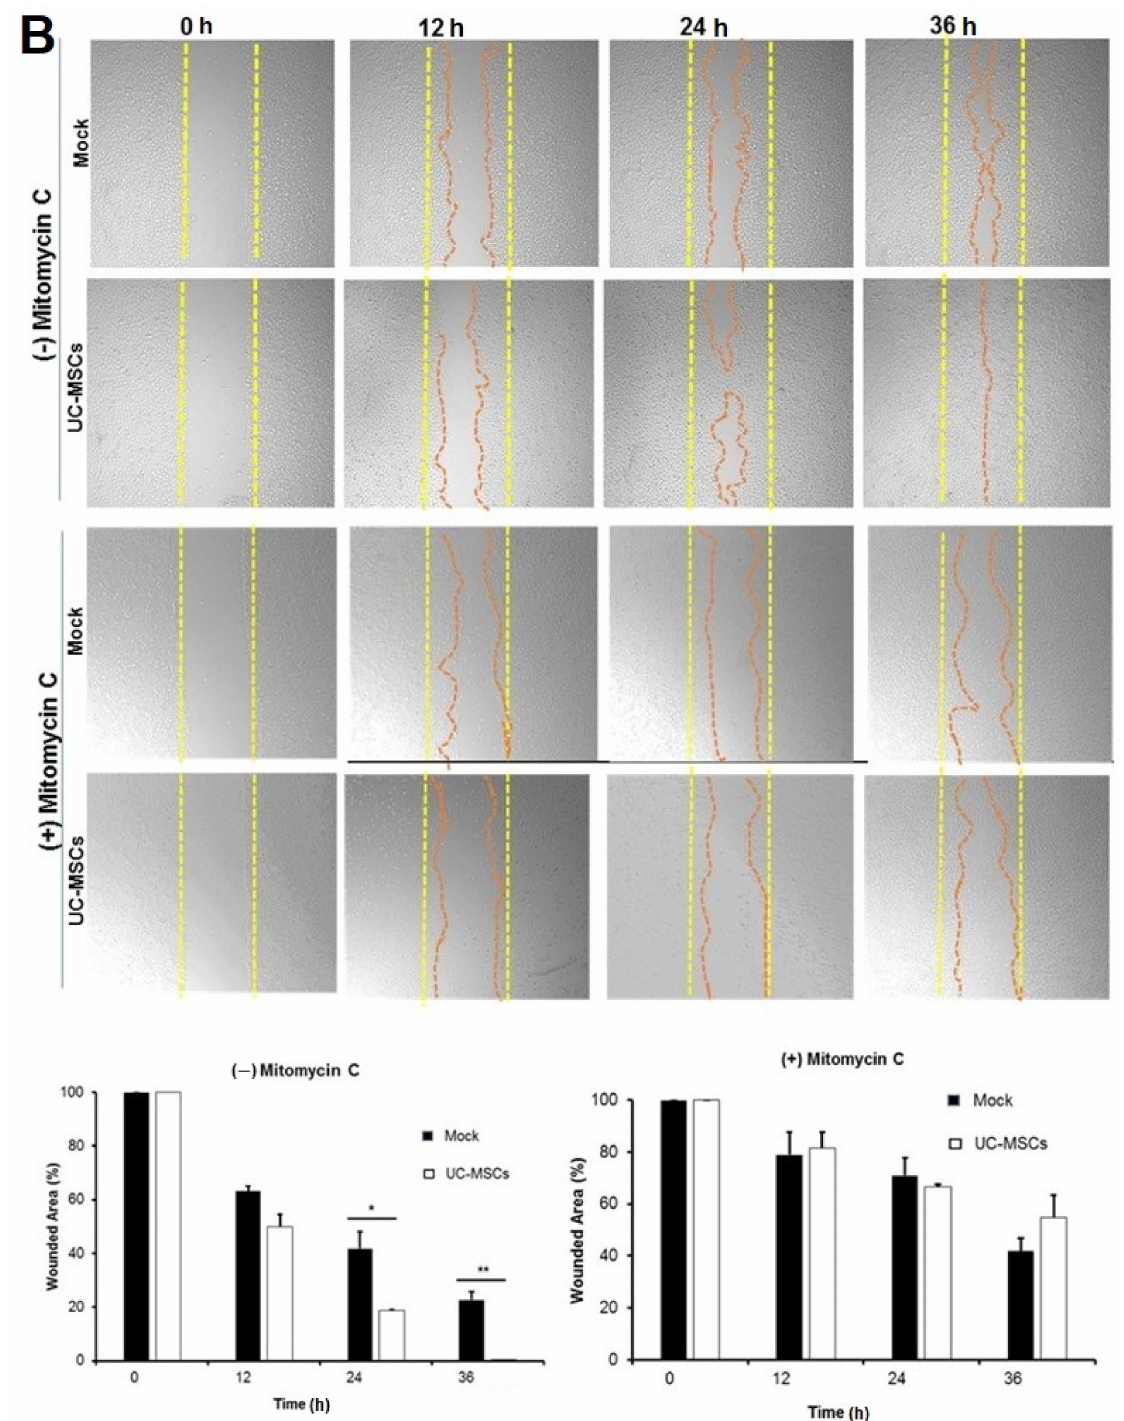
Figure 4. Umbilical cord-derived mesenchymal stem cells accelerate corneal epithelial repair by stimulating the proliferation of corneal epithelial cells in vitro. Scratch assay was used as an in vitro model to study the epithelial repair potential of UC-MSCs in cultured ( A ) rabbit (SIRC) and ( B ) human (HCE) corneal epithelial cell lines. Mitomycin C treatment (10 µ g/mL for 3 h, prior to scratching) was used to inhibit the proliferation of corneal epithelial cells. To mimic epithelial injury, a completely confluent corneal epithelial monolayer was wounded through scratching. Scratched monolayer was incubated with UC-MSCs maintaining indirect contact through culture inserts. Wounded corneal epithelial cells without any incubation with MSCs were used as controls (mock). Epithelial repair was studied through microscopic observations at defined intervals (0, 24, 48, and 72 h in SIRC, and 0, 12, 24, and 36 h in HCE). Total area of the wound/scratch at 0 h was expressed as 100%. Representative data from three independent experiments are shown and values are expressed as mean ± SD (error bar). * p < 0.05, ** p <